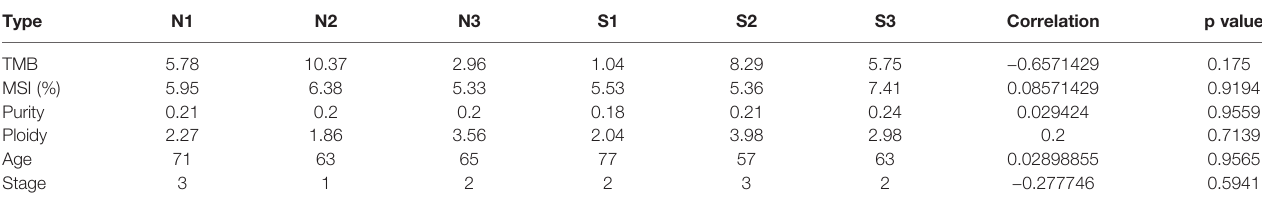
TABLE 2 | Difference of TMB, MSI, and clonality between sensitive and insensitive groups. Type